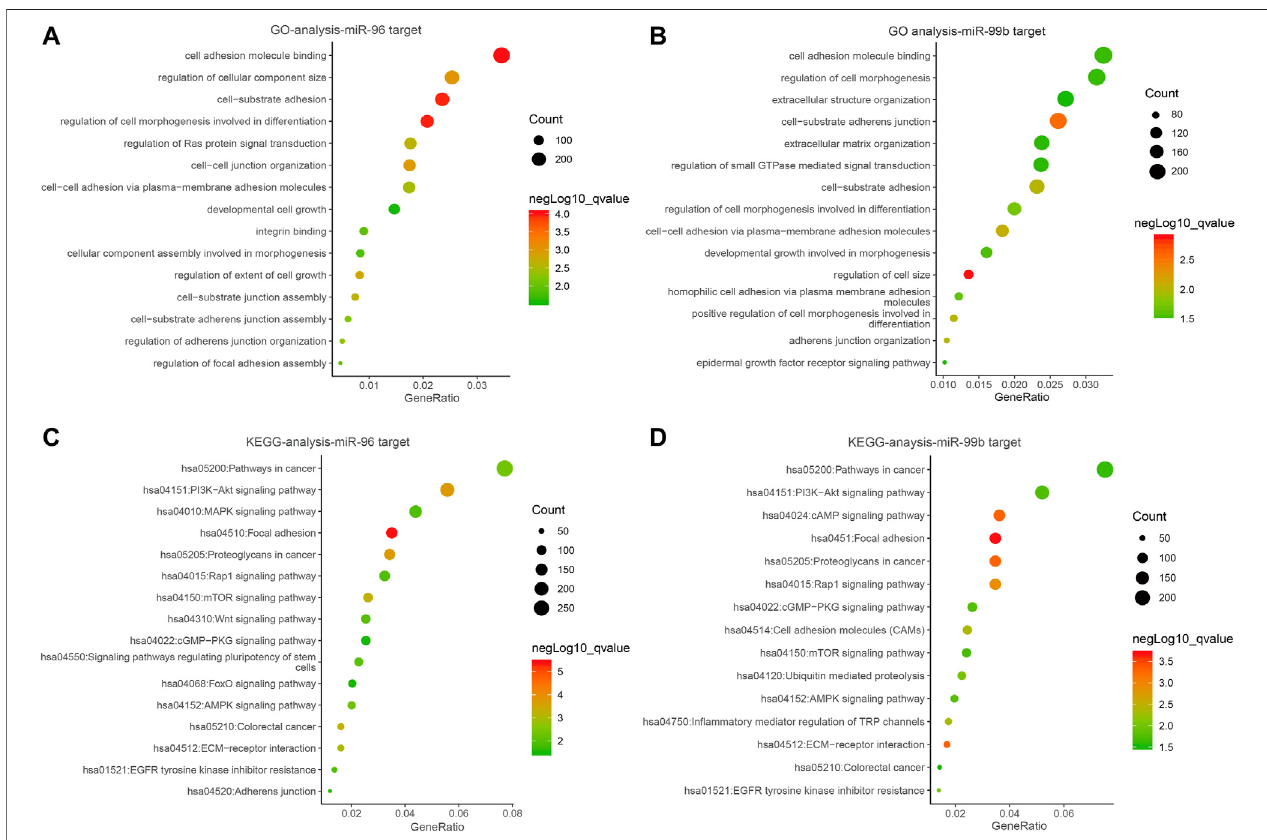
FIGURE 9 | The bubble plot of miRNA bioinformatics analyses. (A,B) Gene ontology (GO) analysis; (C,D) The KEGG signal pathway analyses.